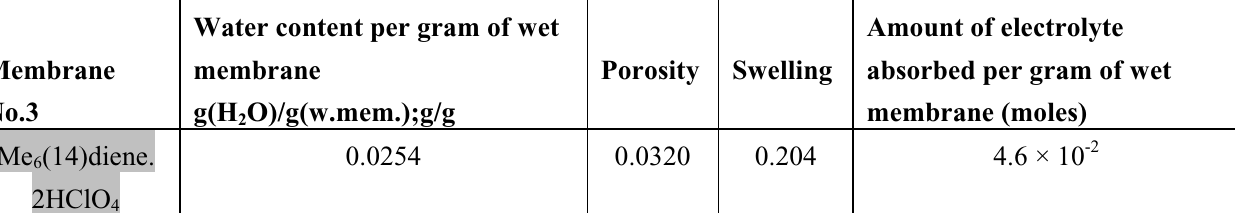
(14) diene.2 HClO 6